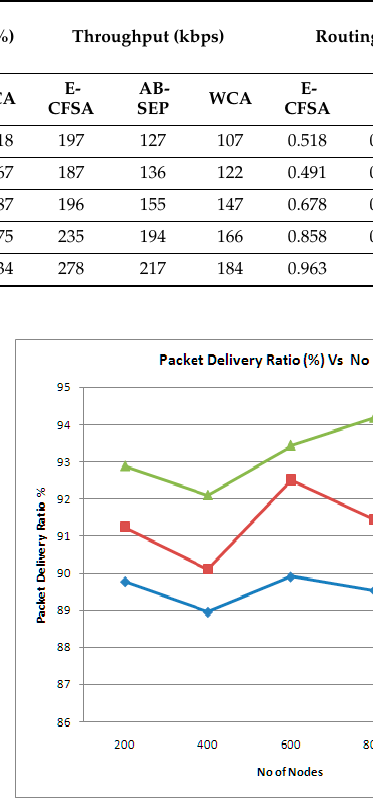
Figure 18. Graph PDR Vs. No. of Nodes.